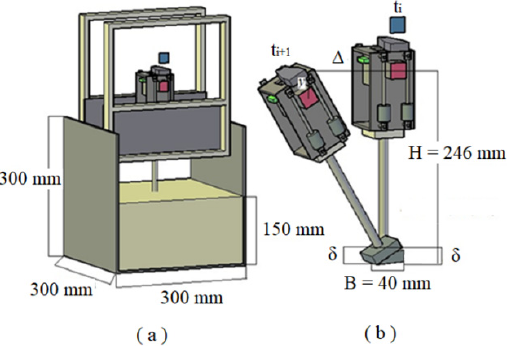
Figure 4. ( a ) Strongbox and sand deposit with measurements, electromechanical oscillator inside the guide; ( b ) rocking motion of the electromechanical oscillator, dimensions needed to convert horizontal displacement Δ into vertical displacement at the edge of the square footing δ .